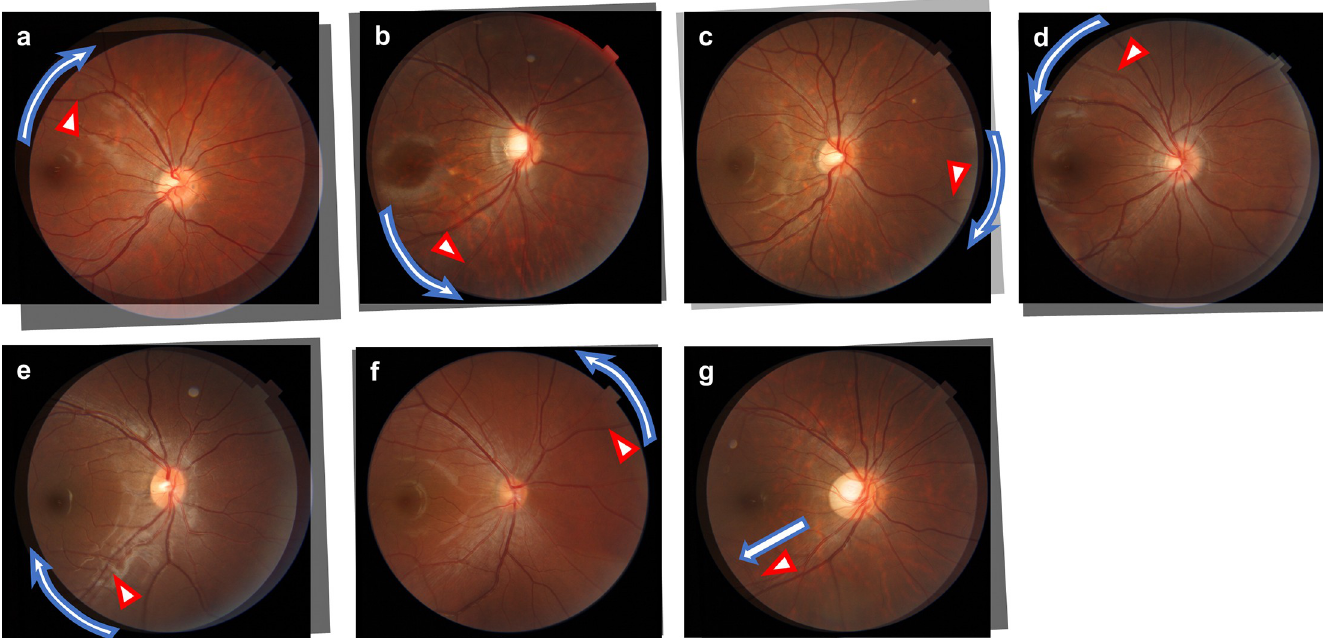
Fig 2. Overlaid images of several types of the retinal vessel shift. Red triangles indicate local mismatching vessels, and white arrows indicate local vessels shift. There were seven types of retinal vessel shifts: (a) supra temporal clockwise, (b) infra temporal anticlockwise, (c) nasal clockwise, (d) supra temporal anticlockwise, (e) infra temporal clockwise, (f) nasal anticlockwise, and (g) temporal